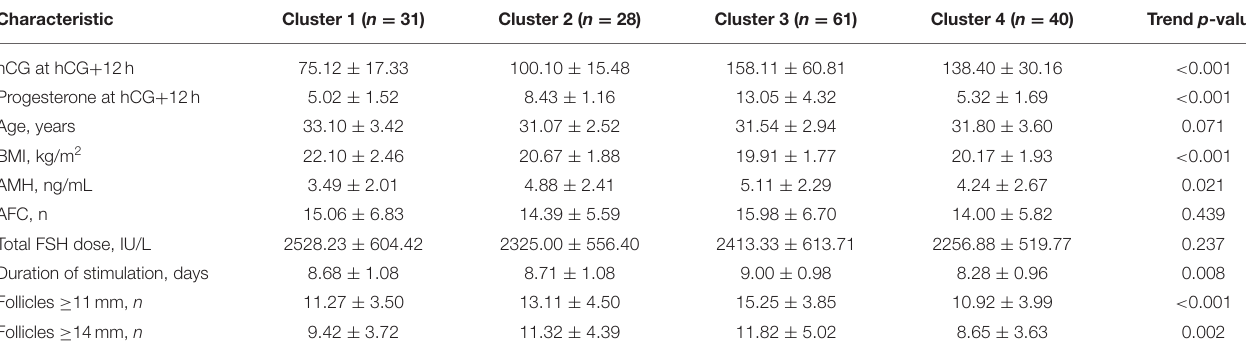
TABLE 5 | Patient characteristics and stimulation outcomes by